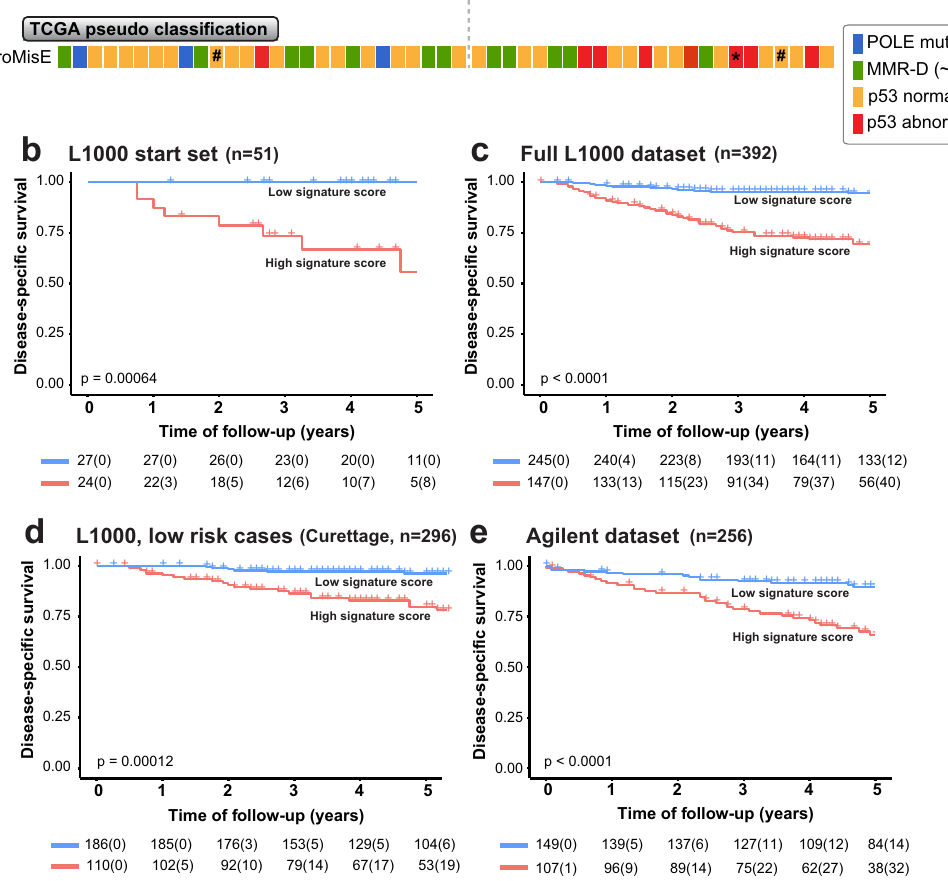
FIGO stage Myometrial infiltration Cervical stroma inv.